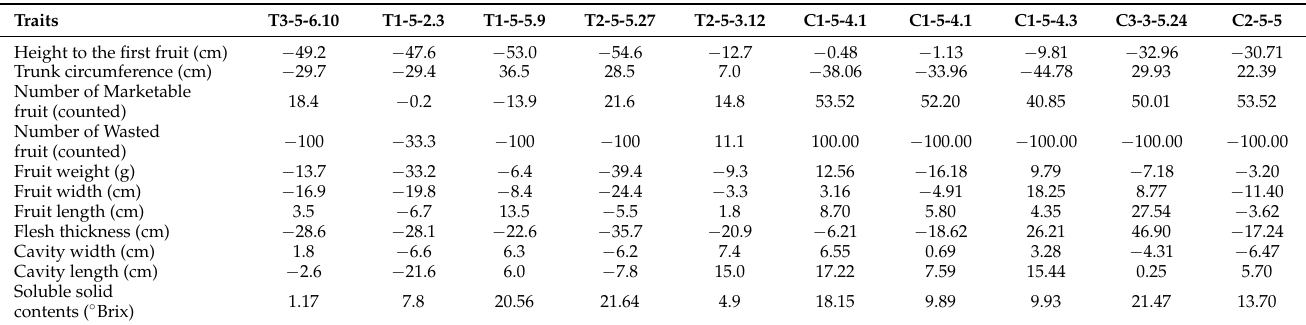
Table 6. Trait gain percentage (%) increased or decreased in each particular trait within each F5 RIL in each environment either (T1 + T2) or (C1 + C2) compared to commercial